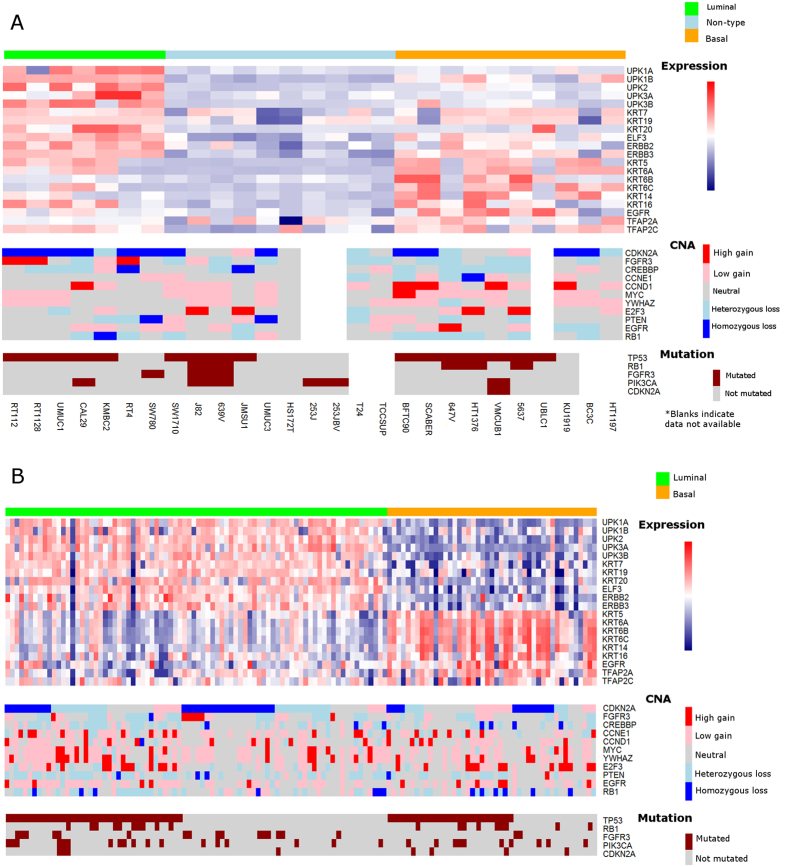
Comparison of CCLE gene expression and genetic data with gene expression and genetic data from the bladder TCGA study identifies human cell lines representative of luminal and basal bladder cancer.(A) CCLE Urinary Tract Cell Line Data, cases organized by expression subtype (Luminal, ”non-type”, and Basal), copy number alterations (CNA), and mutational data, from several genes commonly affected in human bladder cancer. (B) TCGA Urothelial Bladder Cancer Data, cases organized by expression subtype (luminal vs basal), copy number alterations (CNA), and mutational data from several commonly affected genes.